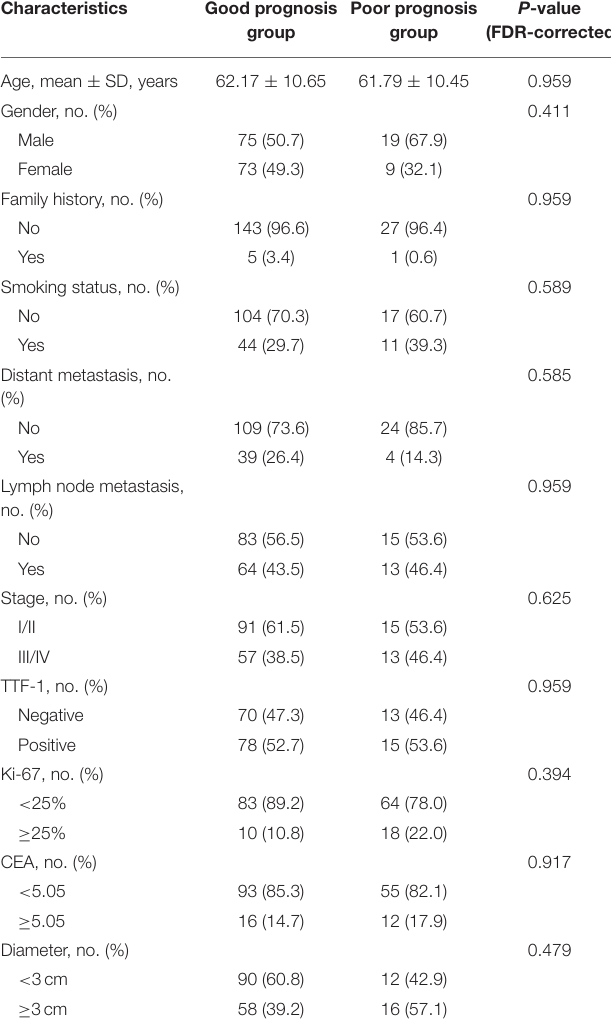
TABLE 1 | The comparison of clinicopathological factors between good prognosis group and poor prognosis group.